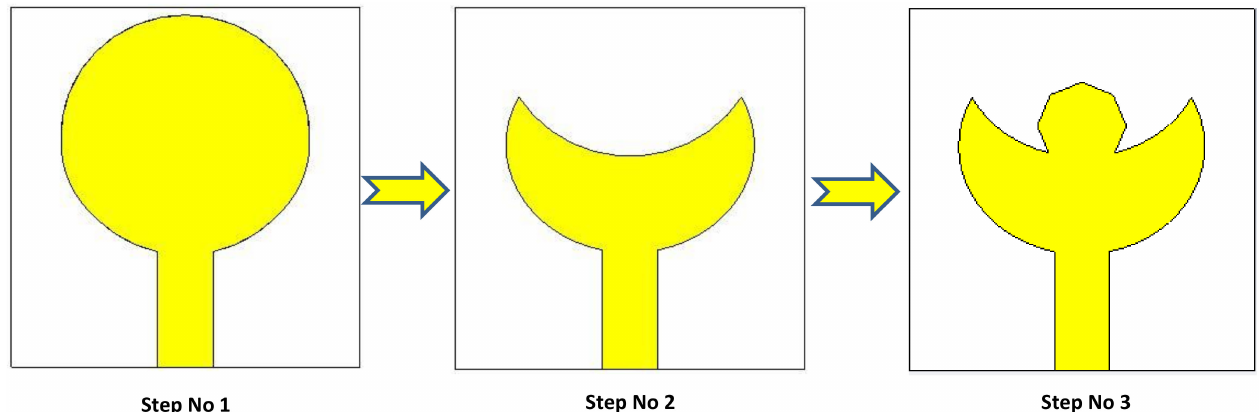
Figure 2. Design steps of Type-A antenna.